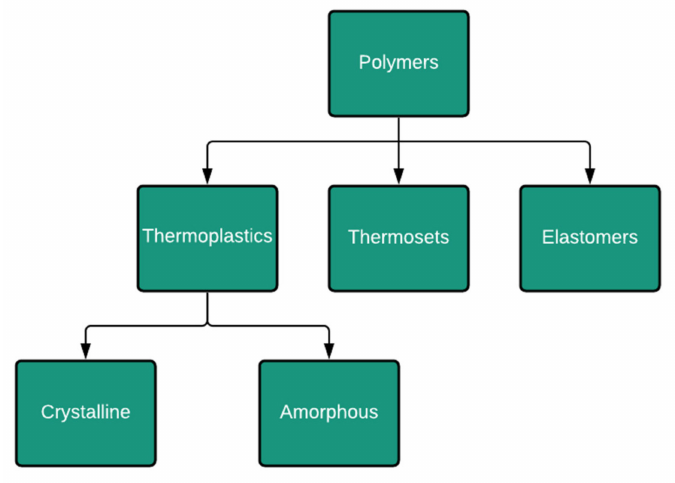
Figure 2. The taxonomic structure of polymers showing the different classification of polymer materials [43]. Licensed under Creative